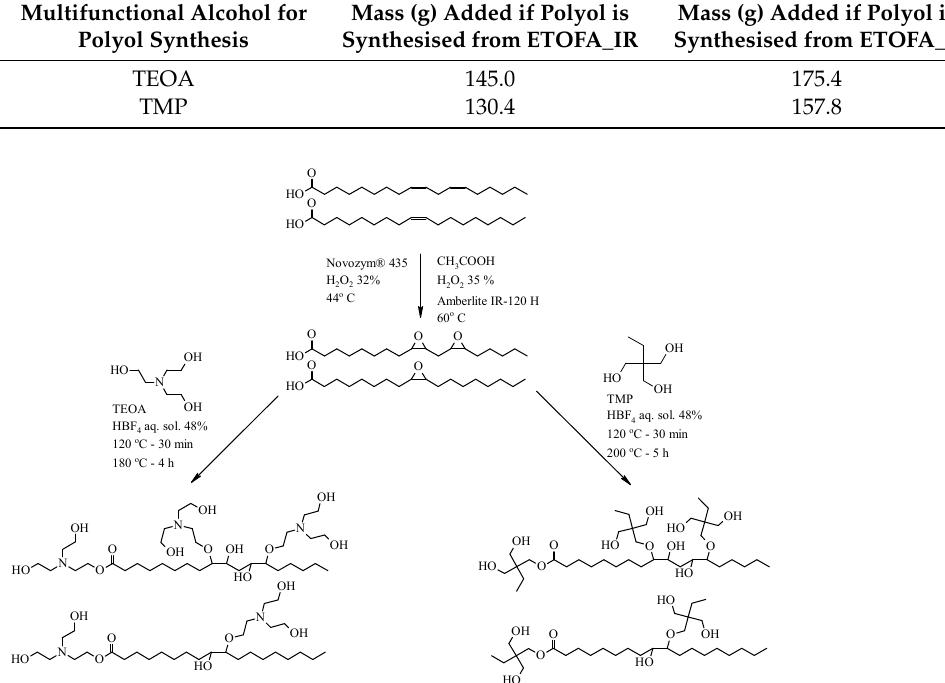
Figure 2. Idealised chemical structure of developed bio-polyols.